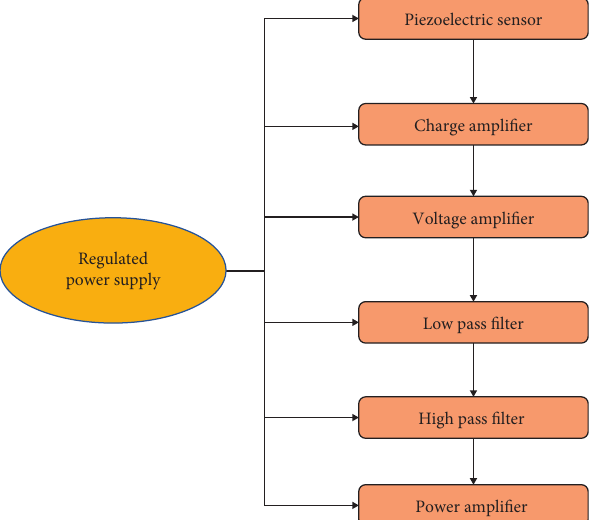
Figure 4: Power supply for piezoelectric sensors.